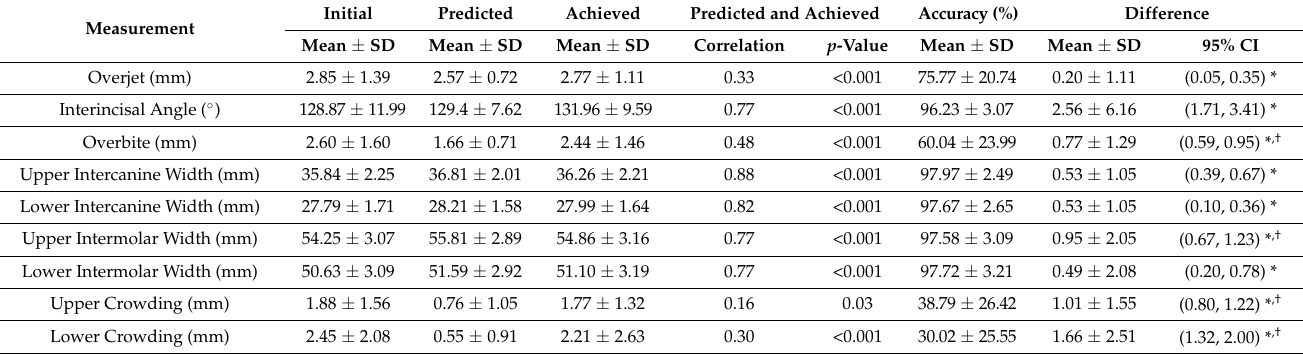
Table 1. This table is assessing the changes in the different dimensions of the patient’s current stage and the final proposed stage by ClinCheck ®